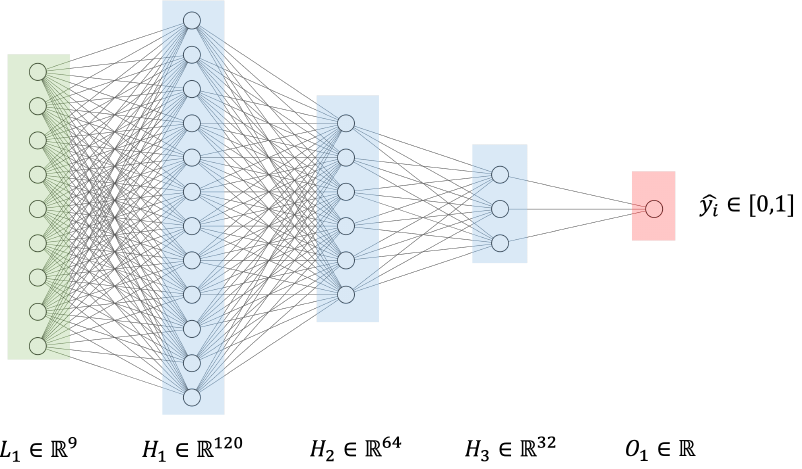
Figure 7. Final DDNN architecture, which consists of an input layer L 1 ∈ R 9 , three hidden layers